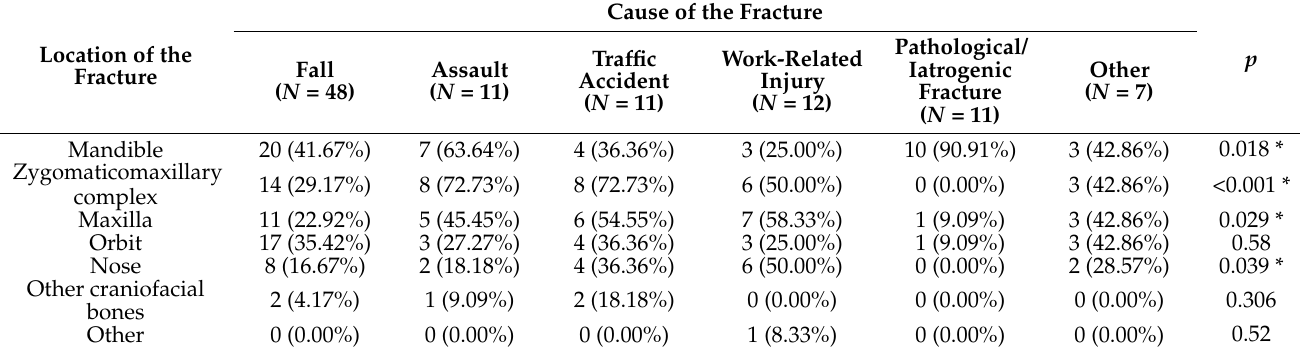
Table 9. Location and cause of fracture.